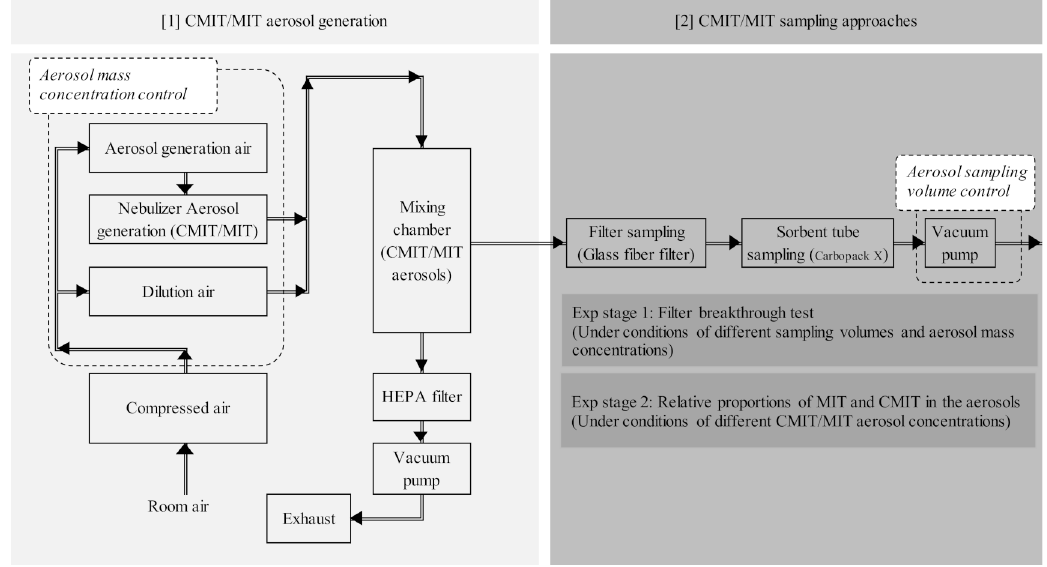
Figure 1. Flow chart for CMIT/MIT aerosol generation and sampling